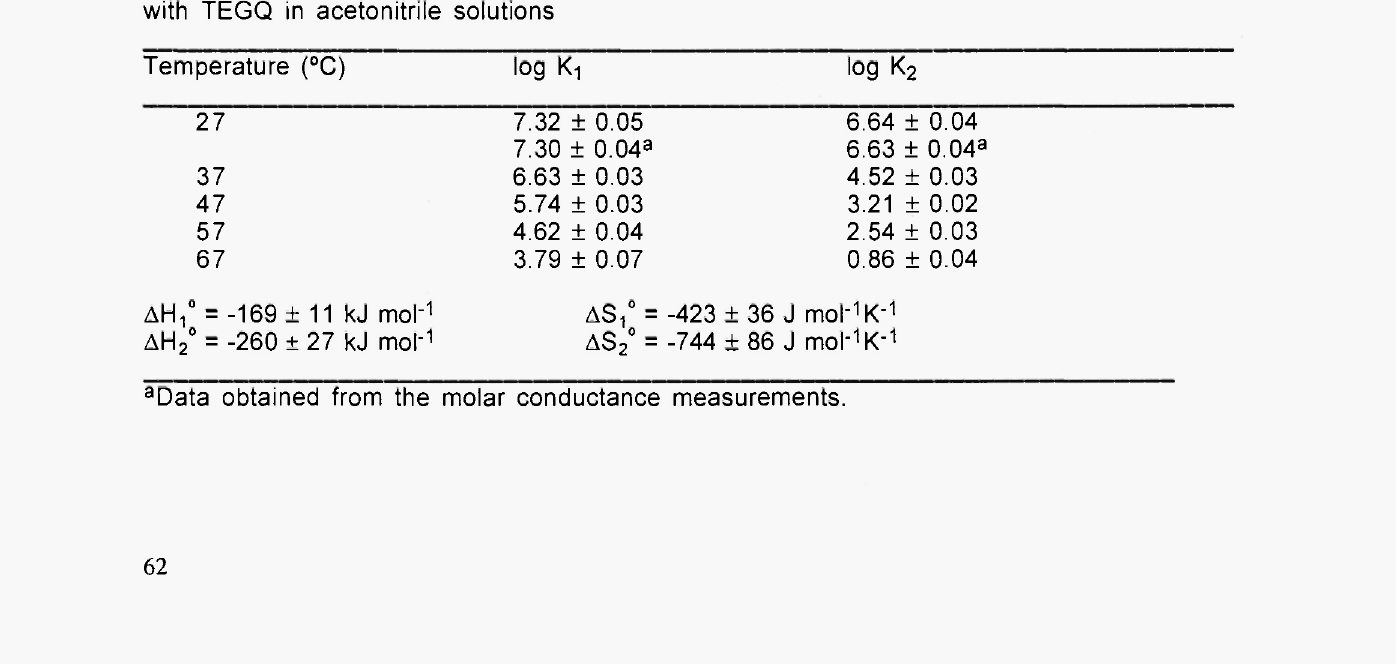
Table II Stepwise formation constants and enthalpy and entropy values for Na + complexes with TEGQ in acetonitrile solutions